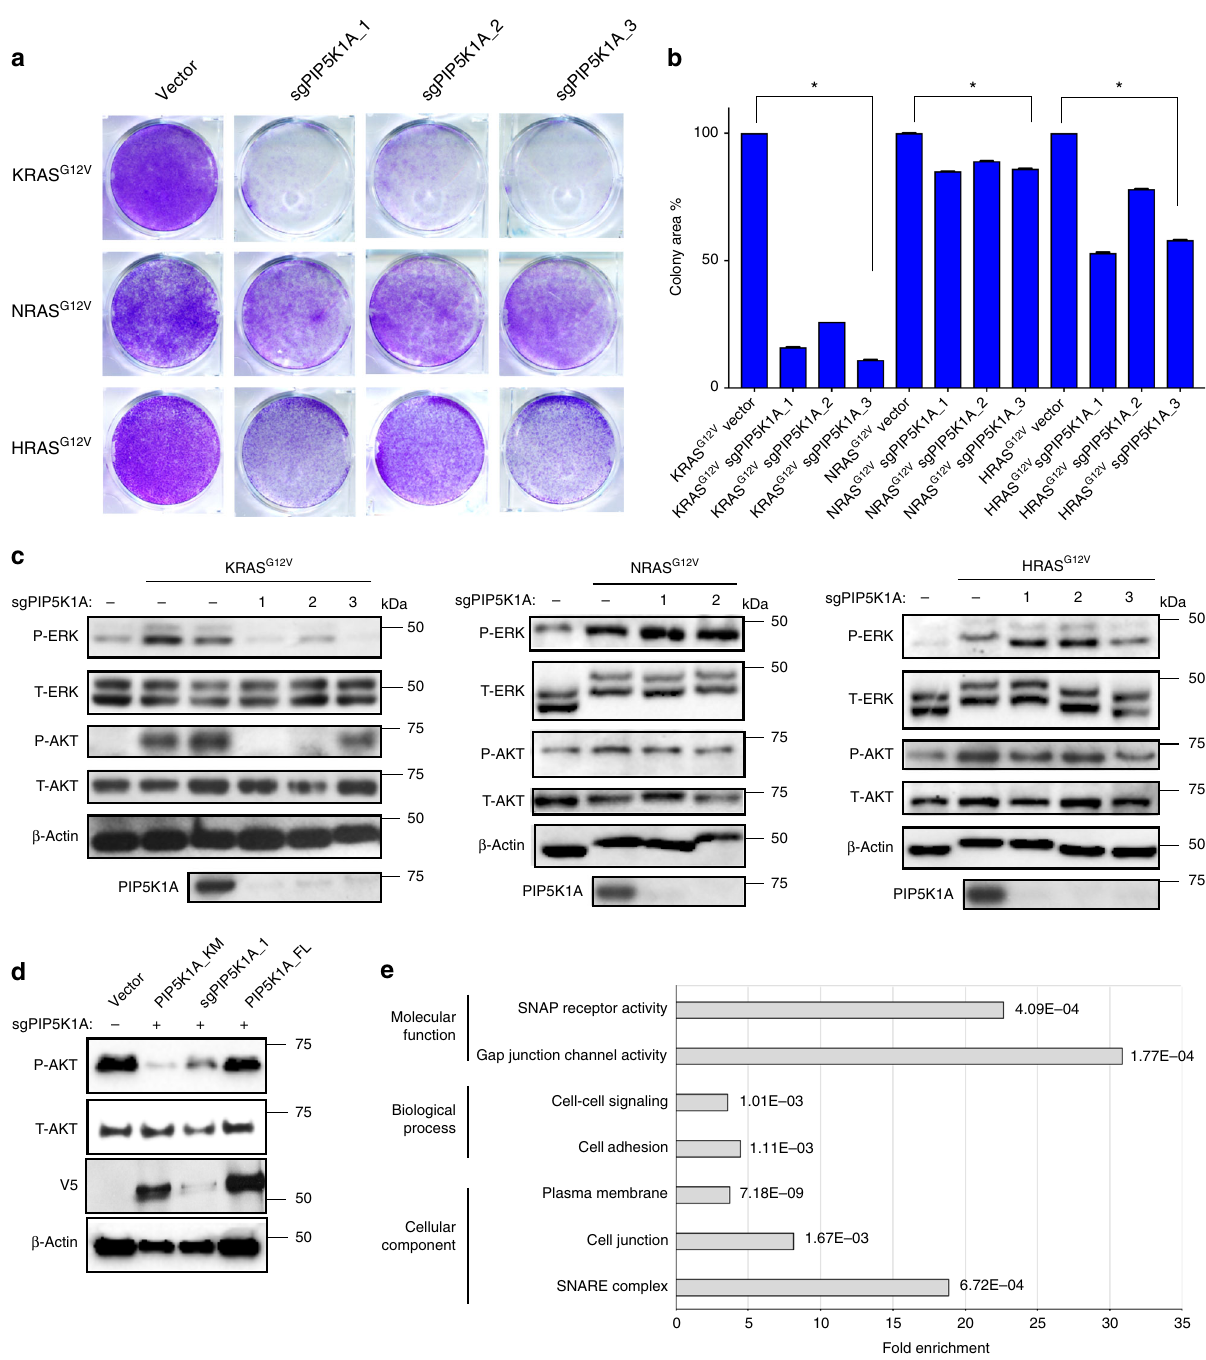
Fig. 4 PIP5K1A mediates oncogenic KRAS signaling. a Representative Crystal Violet staining, b intensity of Crystal Violet staining (mean ± SE, triplicate samples, three experiments, normalized to vector control), and c immunoblot detection of phosphorylated (P-) ERK and AKT and PIP5K1A in cells expressing the indicated RAS G12V proteins in the absence (vector) or presence of up to three separate PIP5K1A sgRNAs. * p = 0.05, one-sided Student ’ s t test. n = 2. d Immunoblot detection of P-AKT in Capan-1 cells stably transduced with a vector encoding Cas9 and no sgRNA ( − ) or PIP5K1A_1 sgRNA ( + ) and another vector encoding no transgene (vector), wild-type PIP5K1A, or PIP5K1A KM (detected with an α -V5 antibody). n = 2. e GO classi fi cations showing fold enrichment and signi fi cance ( p values, Fisher ’ s exact test) based on GO enrichment analysis of proteins biotinylated by BirA*-KRAS G12V in the absence or in the presence of PIP5K1A. Where indicated, total (T-) ERK and AKT as well as β -actin serve as loading